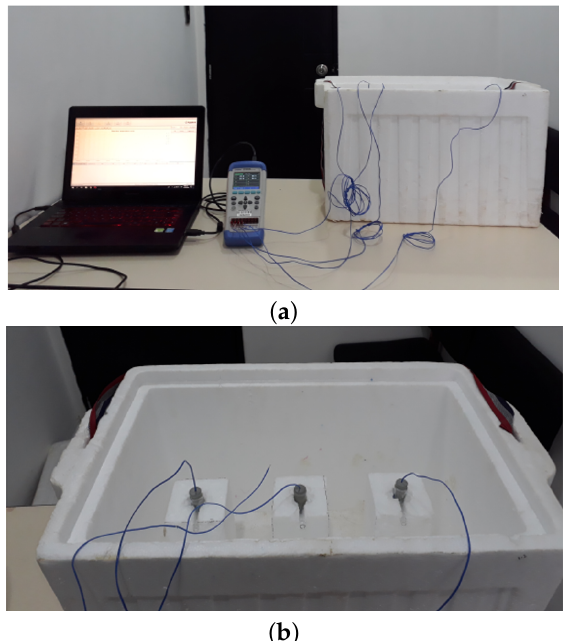
Figure 7. ( a ) Experimental setup implementing the scheme of Figure 2; ( b ) Insulation of the test specimens.